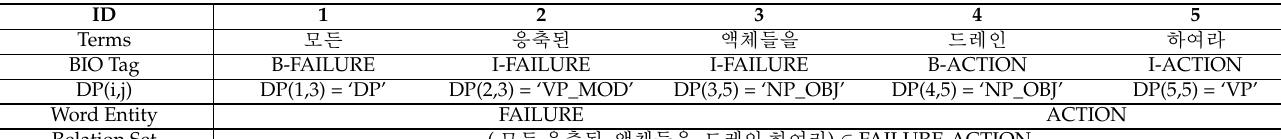
Table 6. An example of the results by applying Rule #4.